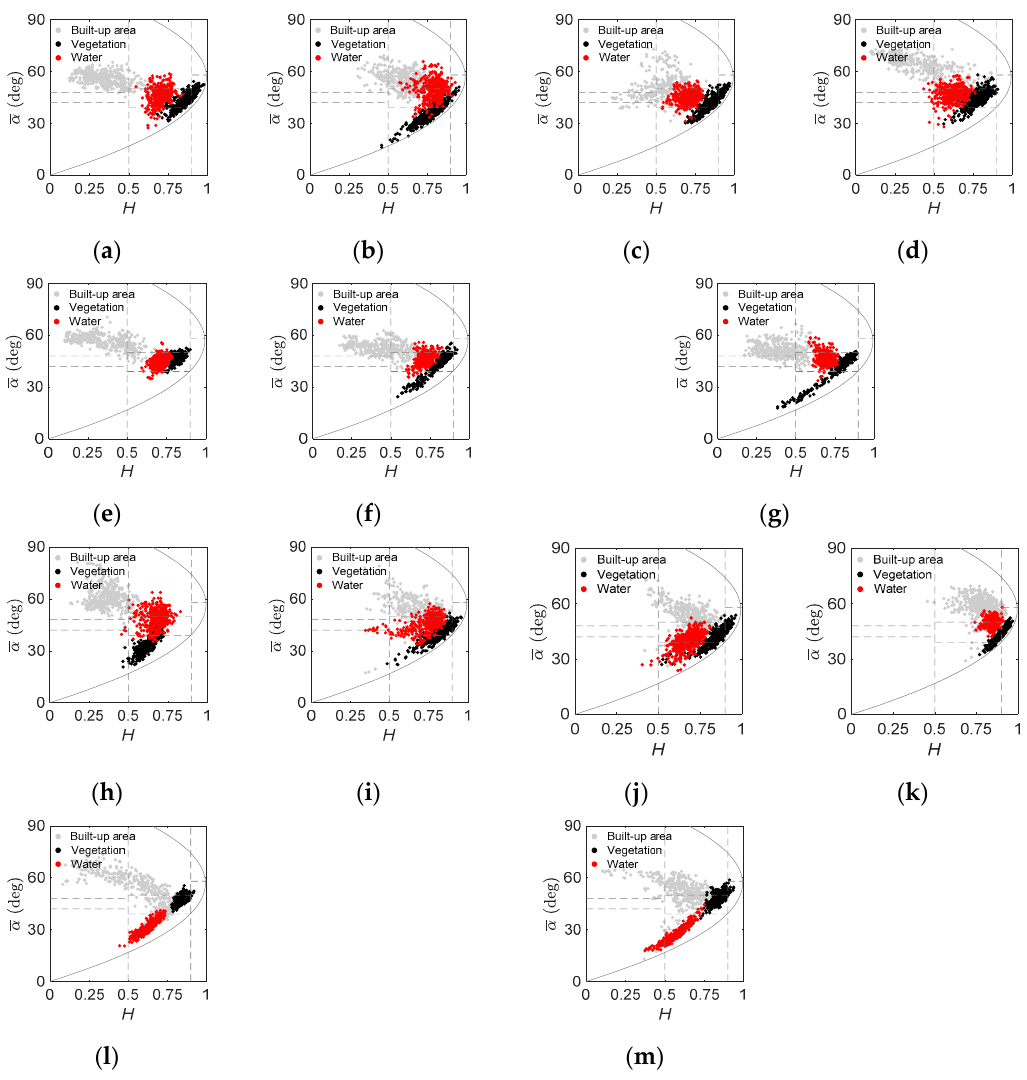
Figure 7. H- α distribution of built-up areas, vegetation, and water. ( a ) GF-1703, ( b ) GF-1710, ( c ) GF-1712, ( d ) R2-0903, ( e ) A2-1603, ( f ) A2-1610, ( g ) A2-1612, ( h ) GF-1702, ( i ) GF-1705, ( j ) GF-1708, ( k ) R2-1607, ( l ) A2-1504, and ( m ) A2-1601.